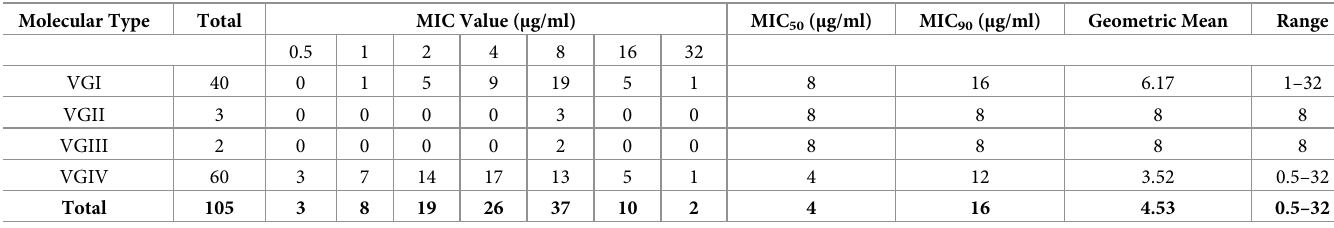
Table 1. The fluconazole minimum inhibitory concentration (MIC) distribution, MIC 50 , MIC 90 , geometric mean and range (in μ g/ml) represented by molecular type of the 105 tested South African Cryptococcus gattii isolates from enhanced laboratory-based surveillance collected between 2005 and 2013. Molecular